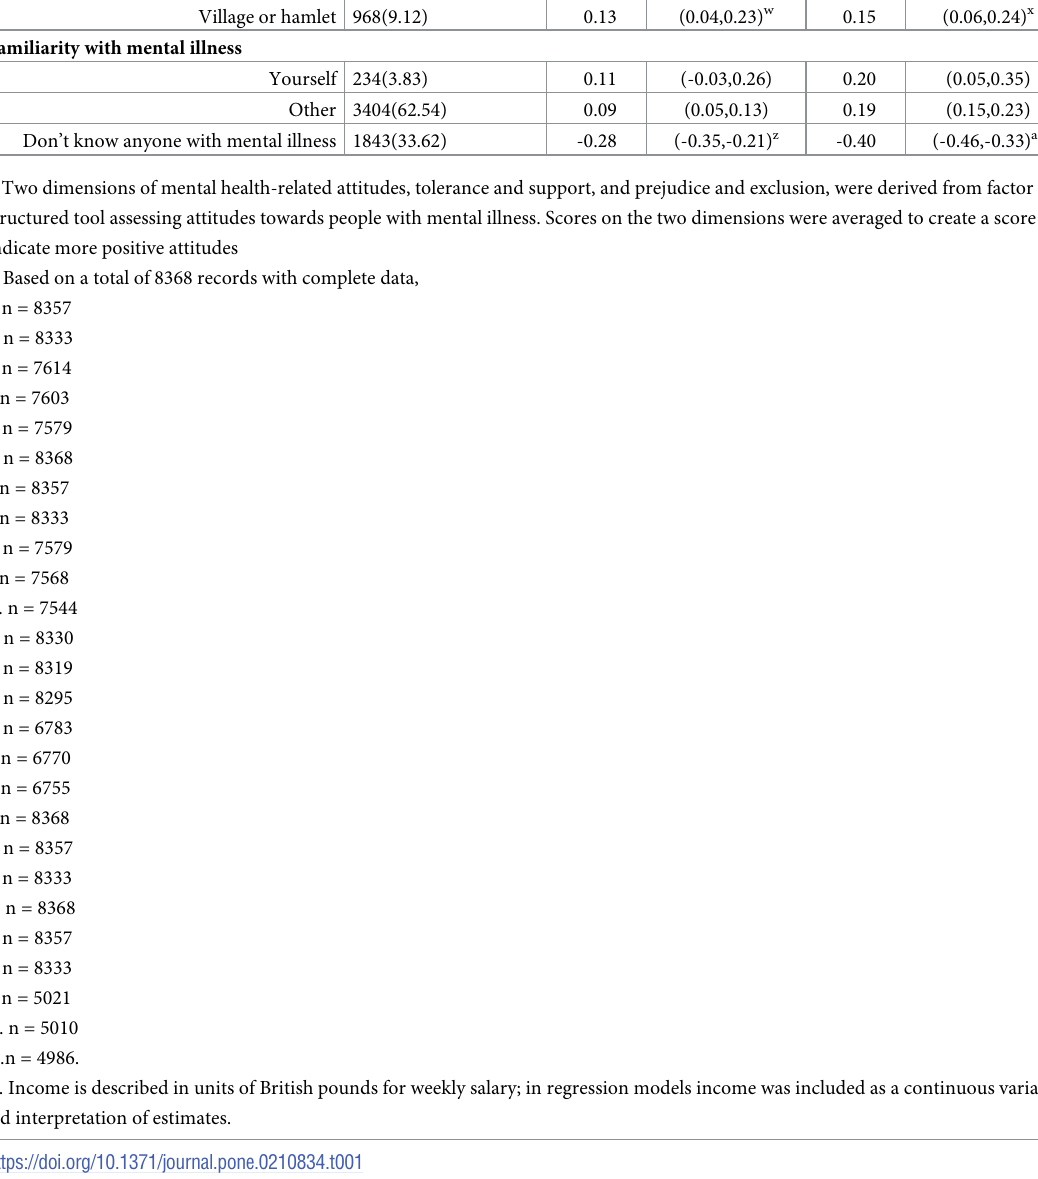
models are presented in Table 4. Based on the final analytic sample, distribution of mean scores on mental health-related attitudes by each covariate were inspected (Table